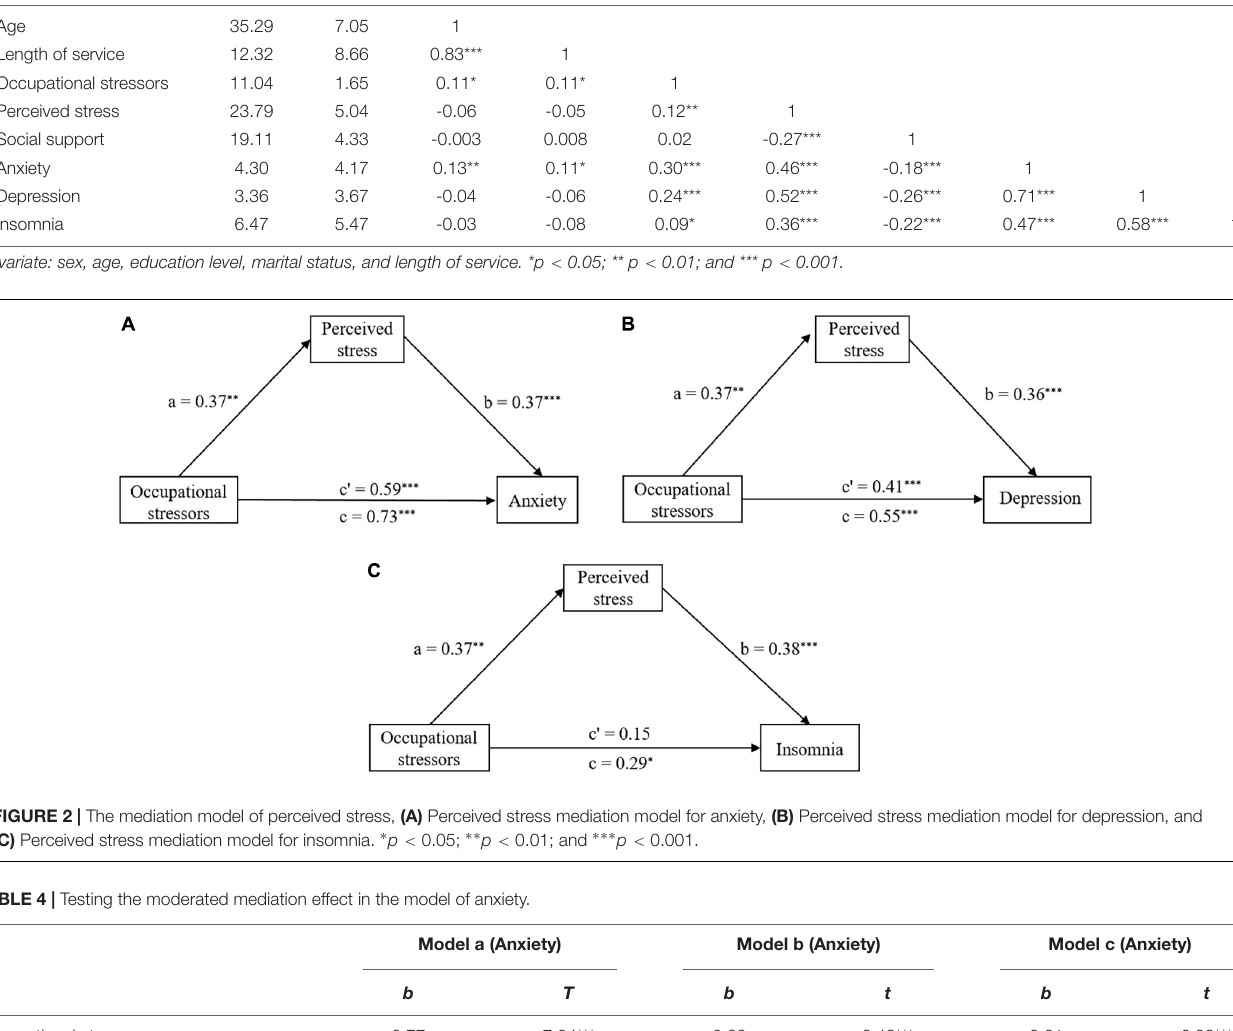
TABLE 3 | Means, standard deviations, and correlations among study variables. Variable